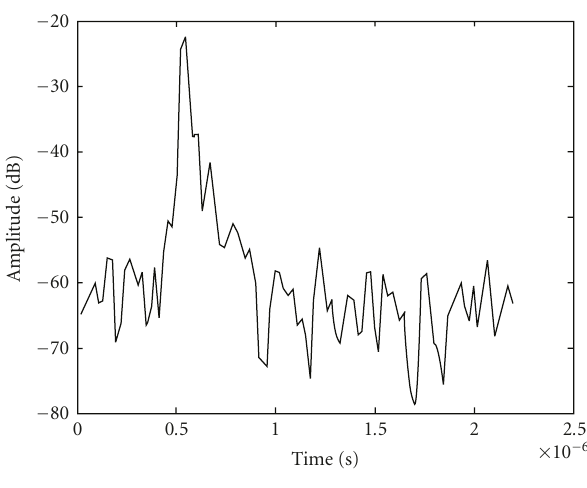
Figure 8: Power delay